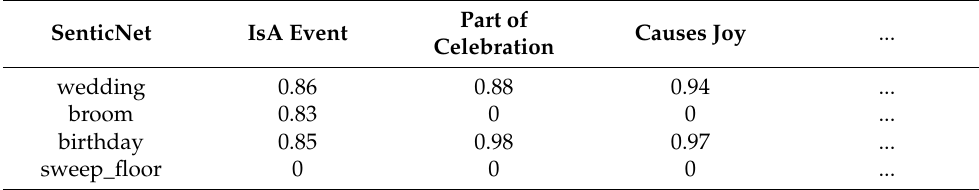
Table 1. Example of new knowledge concepts inferred from SenticNet. Part of SenticNet IsA Event Causes Joy ... Celebration wedding 0.86 0.88 0.94 ... broom 0.83 0 0 ... birthday 0.85 0.98 0.97 ... sweep_floor 0 0 0 ...